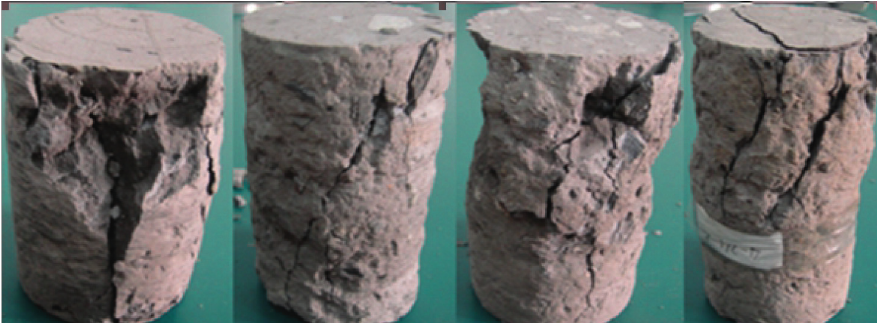
Figure 9: Photograph of broken filling paste after uniaxial compression test.